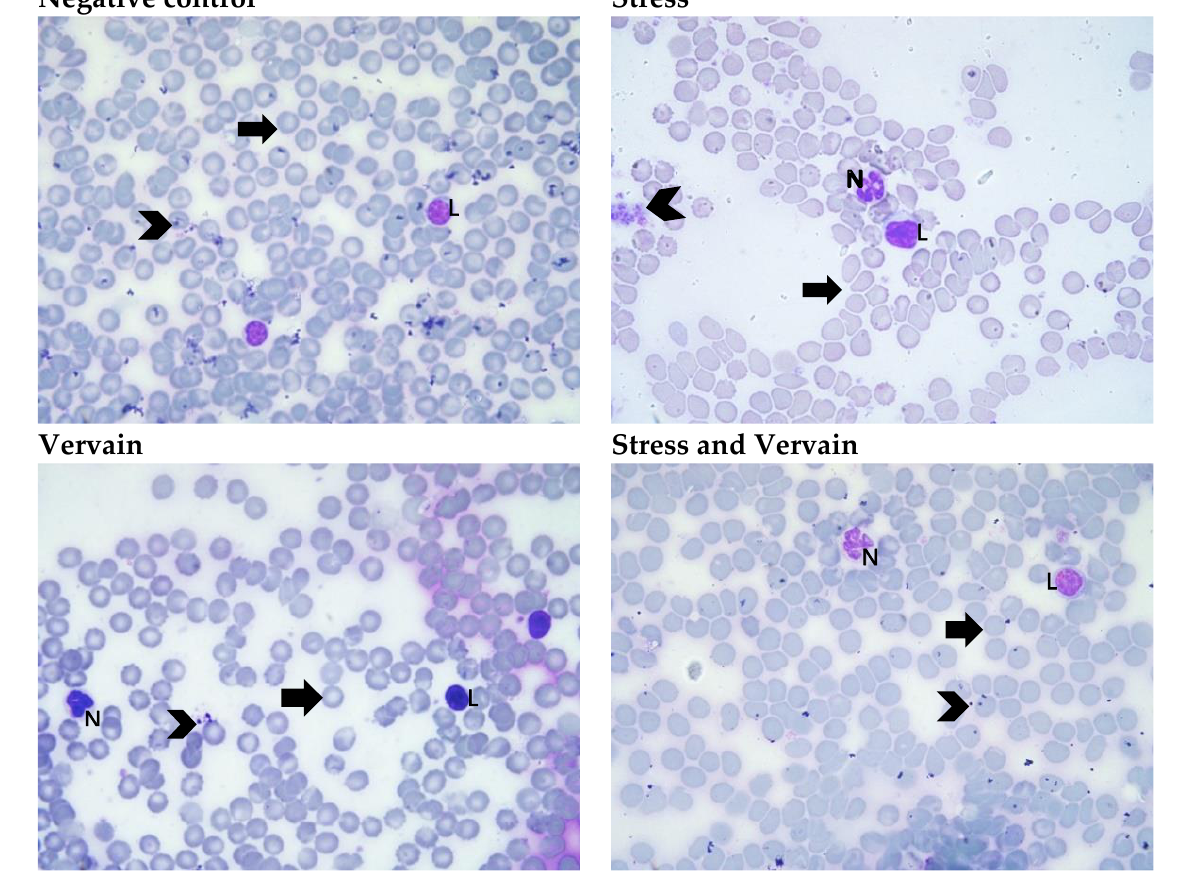
A t = 400 × . Arrowhead (platelets), N (neutrophils), L (lymphocytes), Arrow